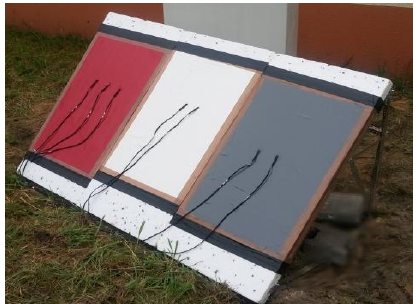
Figure 1. View of the tested partition.